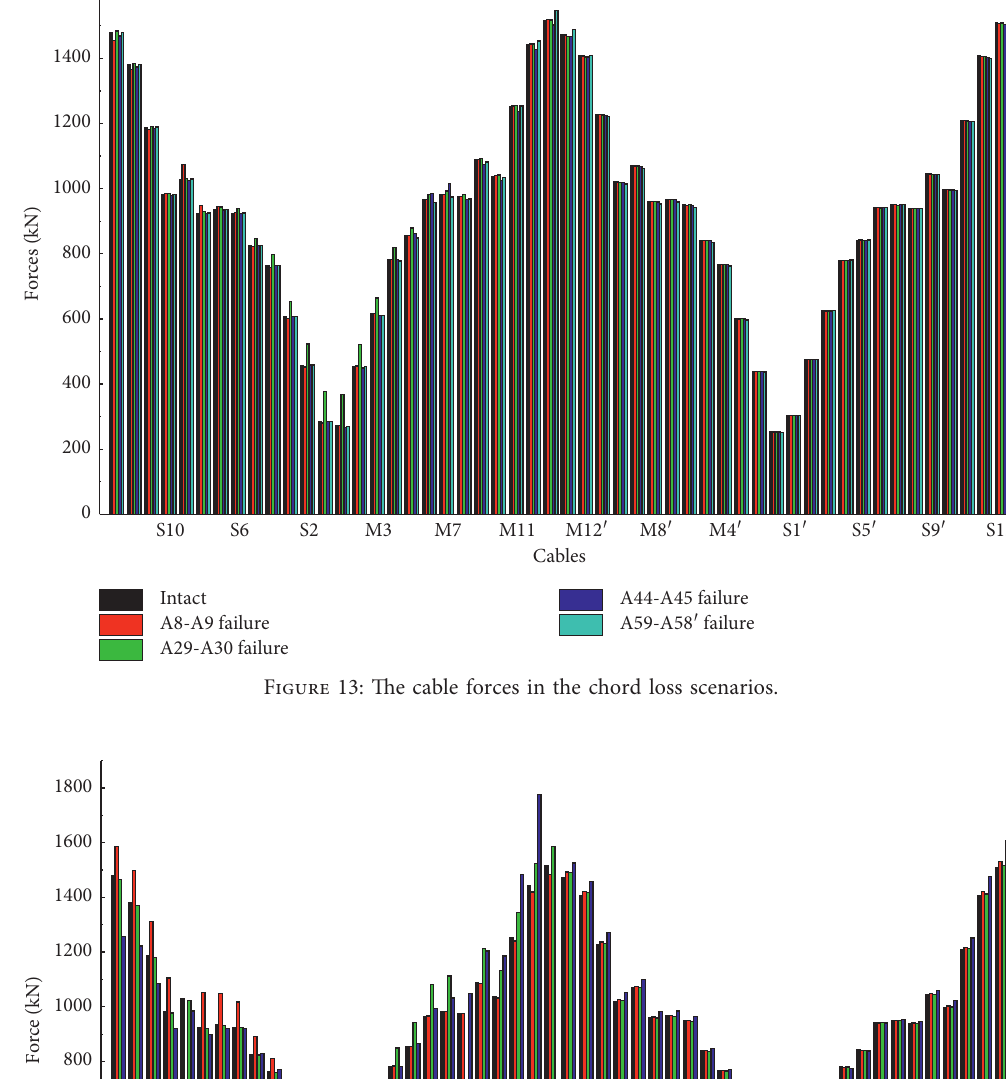
Figure 14: The cable forces in the cable loss scenario.